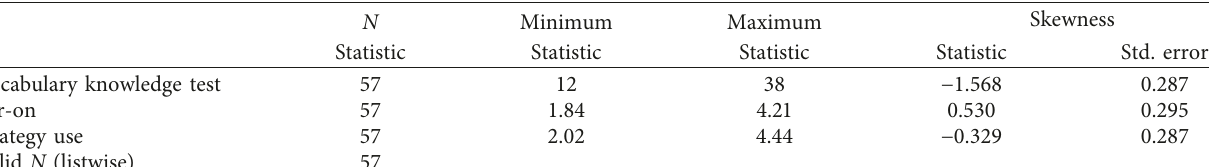
Table 3: Descriptive statistics of the three variables.